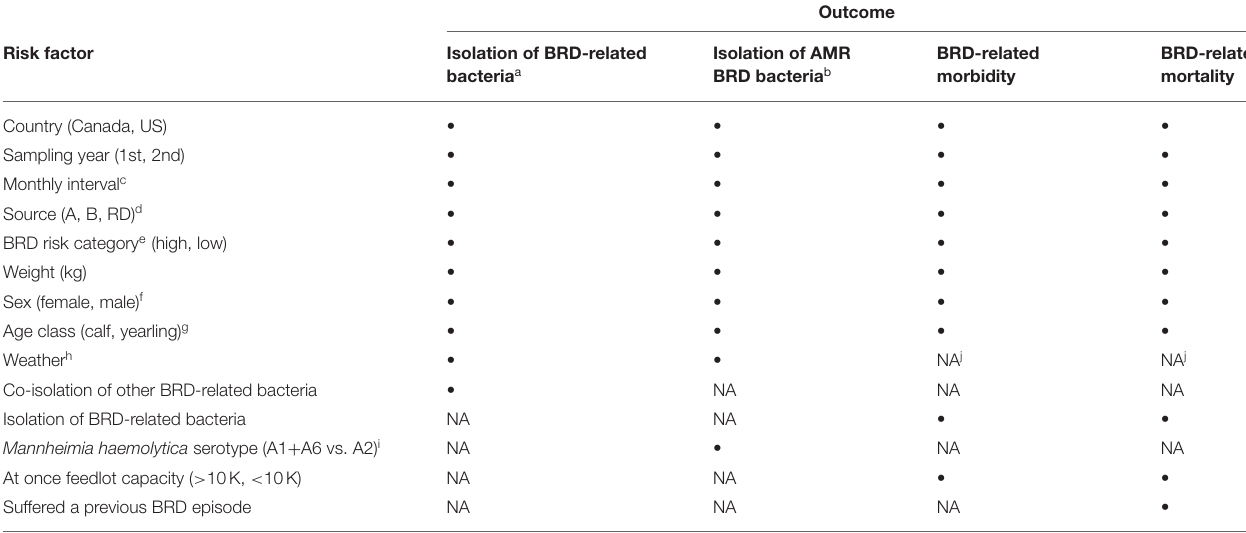
TABLE 2 | Risk factors and outcomes investigated by multivariable logistic regression for beef and dairy-type cattle upon feedlot arrival. Risk factor Isolation of BRD-related